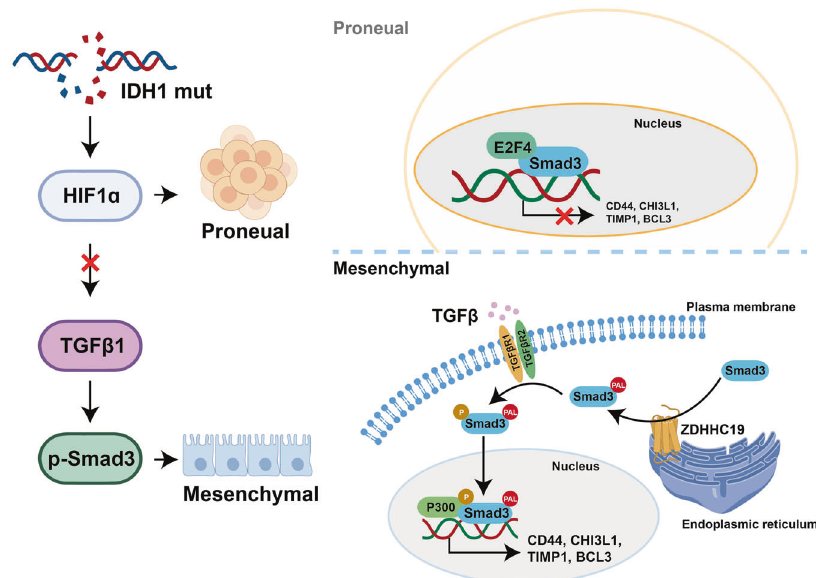
Fig. 6 Schematic diagram. IDH1 mutation suppressed the TGF- β signaling pathway and E2F4 interacted with Smad3 to inhibit expression of mesenchymal markers in the proneural subtype of GBM. However, palmitoylation of Smad3 mediated by palmitoyltransferase ZDHCH19 promoted activation of the TGF- β signaling pathway and its interaction with EP300 to promote expression of mesenchymal markers in the mesenchymal subtype of GBM. GBM glioblastoma, IDH1 isocitrate dehydrogenase